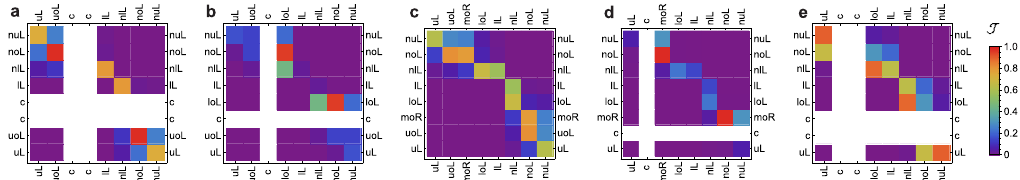
Figure 5: Degree of entanglement (4) between the 8 outgoing modes for the five typifying frequencies of Fig.3. Here c indicates a complex mode; ul , nl , ll , nul are the non-optical